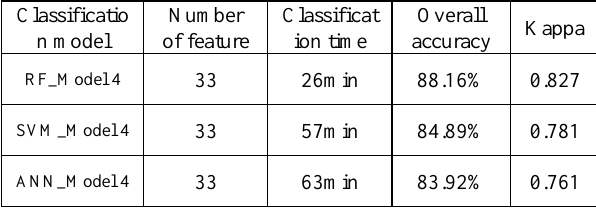
Table 4. Overall accuracy assessment of different method